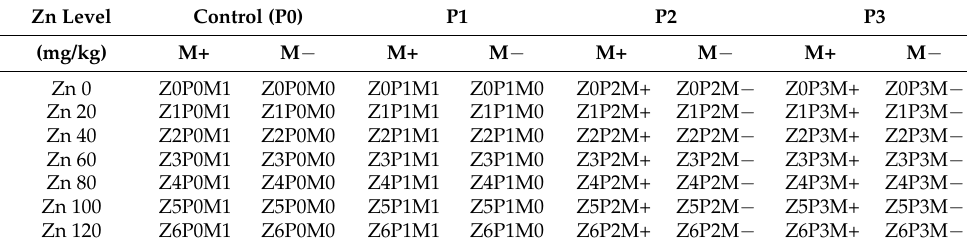
Table 1. Treatment